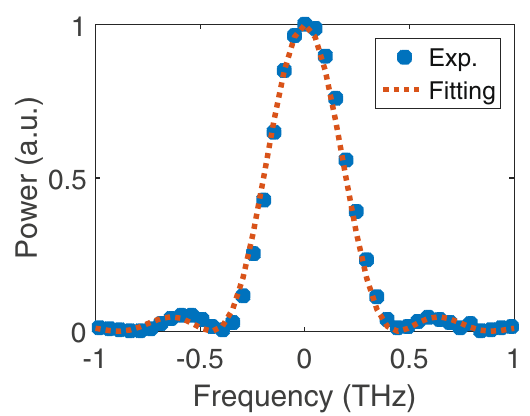
Figure 11. Phase matching profile of the PPLN waveguide. Blue dots show the experiment results at 40 ° C and dashed line shows the sinc 2 fitting, plotted against the frequency offset of the SH wave from the phase matching peak (779.825 nm). The FWHM phase matching bandwidth is about 400 GHz centered at 779.825 nm, which is equivalent to 200 GHz for the lightwaves centered at 1559.65